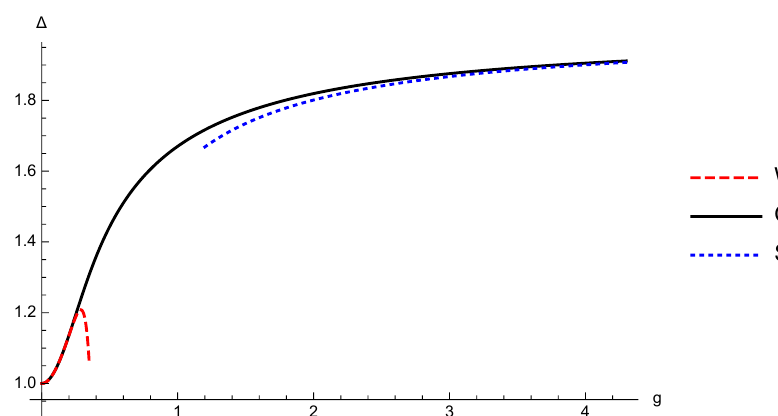
Figure 2 . Numerical data for the case with (cid:30) = (cid:18) = 0, depicted by the solid black line. The dashed red line depicts our (cid:12)ve-loop result at weak coupling, see eq. (1.4). Our data reproduces the strong coupling result derived in [30] depicted by the dotted blue line. At (cid:12)nite coupling it interpolates between